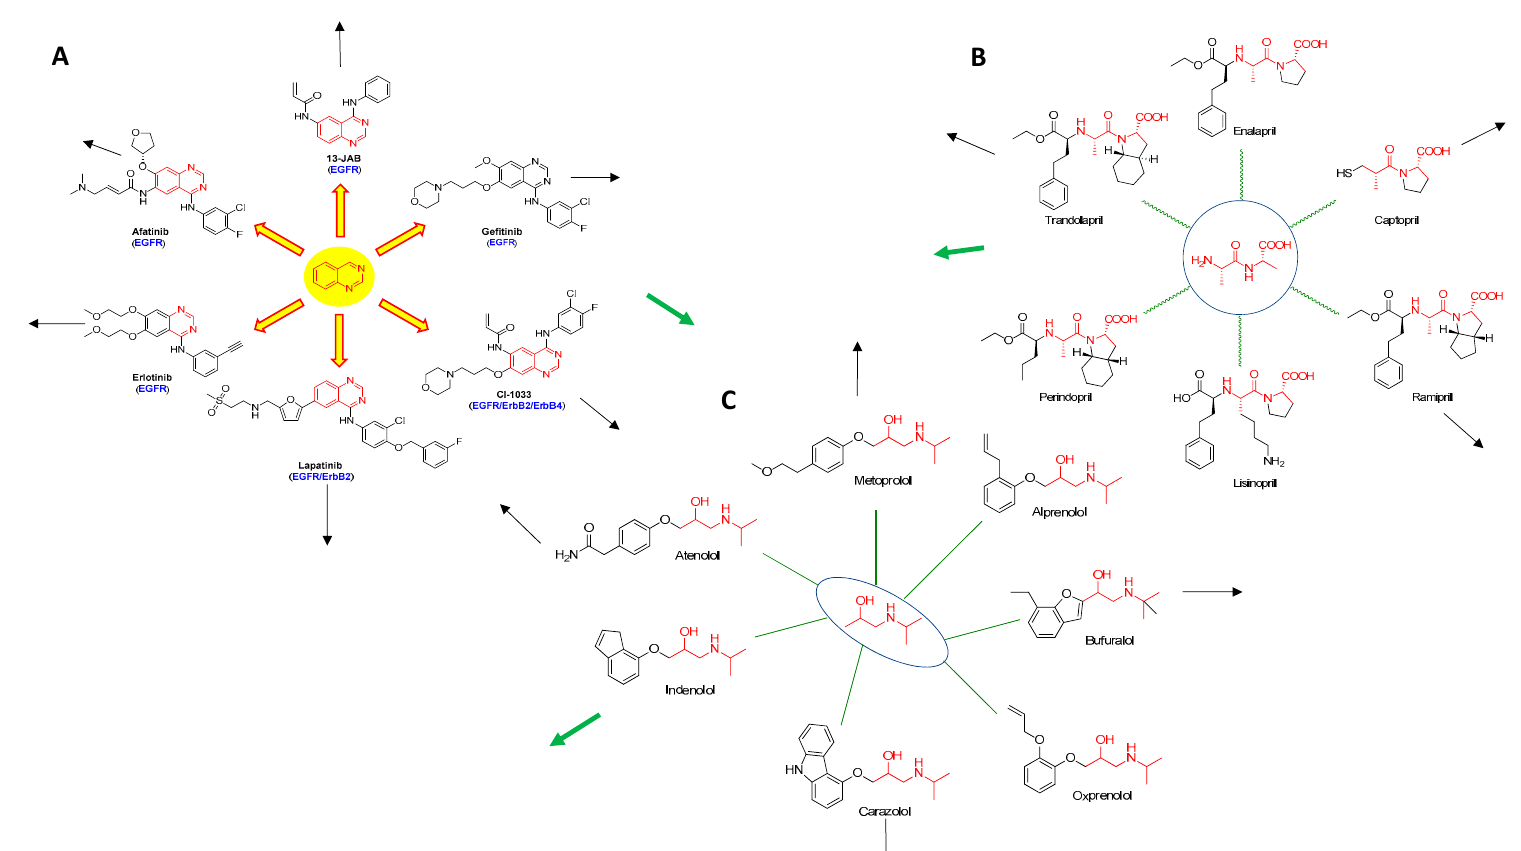
Figure 2. Erdos interactome representations of drugs. Many drugs developed for a given indication usually share a common core motif. Substitutions are made on this core scaffold to tune the biological and drug-like properties and generate intellectual property. An Erdos interactome representation for drugs available or designed to treat a particular disease can be built with the drugs closest to the center sharing that core. More distant members in this interactome will more than likely have different cores. At the farthest reaches of this interactome, members might find use in other disease as their structures (green arrows) might resemble or completely overlap with drugs designed for other indications. ( A ) Part of the receptor tyrosine kinase inhibitors interactome centered around a quinazoline core. ( B ) Part of the angiotensin converting enzyme inhibitors interactome centered around an aminopropanamido-propanoic acid core. ( C ) Part of the beta blockers interactome centered around an isopropylamino-propan-2-ol core.